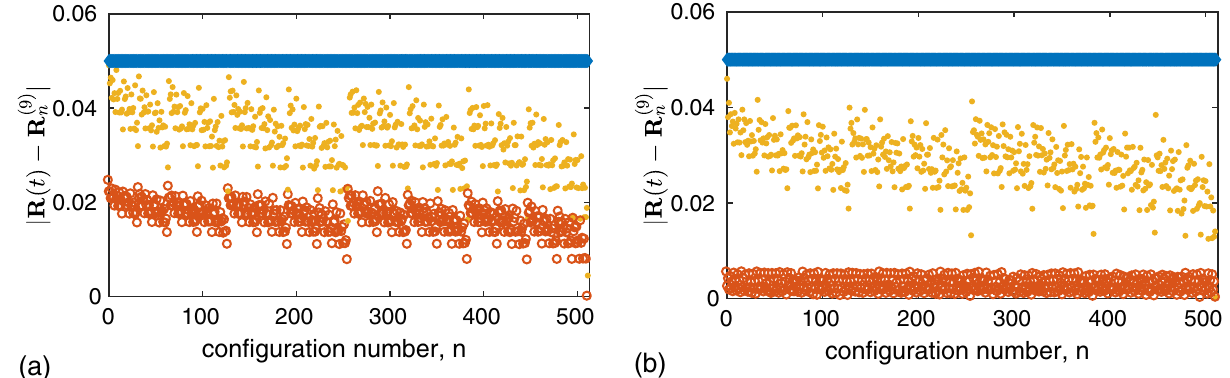
Figure 7. Numerical simulation of Eqs. (3) and (6) for a nine-leaf star network with 512 different initial ( 9 ) conditions R ( 0 ) , each of which is close to the state R n of a particular predicted asymptotic configuration with 0, . . . , 511 . Panels ( a ) and ( b ) correspond to the sigmoid boundary function with µ number n = the Heaviside step boundary function, respectively. The frequencies (ω 1 , . . . , ω 8 , ω 0 , ω 9 ) , written in ascending order, are equidistantly distributed in the interval [0.6, 1]. The states R ( 0 ) are chosen so that the initial distances R ( 0 ) R ( 9 ) n | shown in blue squares are the same for all configurations. The yellow dots show the values of the | − R ( t ) R ( 9 ) 300 , and the red circles at time t corresponding distances n | at time t = | − 0.001 , τ 0.15 , τ 0.3 , and α 1 ε = = + = − =